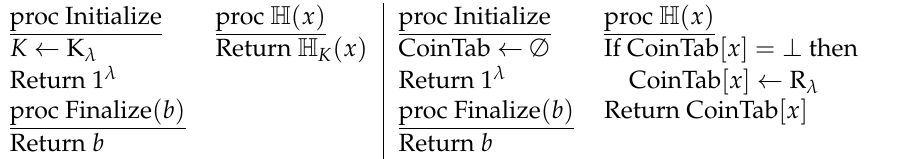
Figure 2. Games defining security for a pseudo-random function H . Game REAL is on the left while Game RAND is on the right.